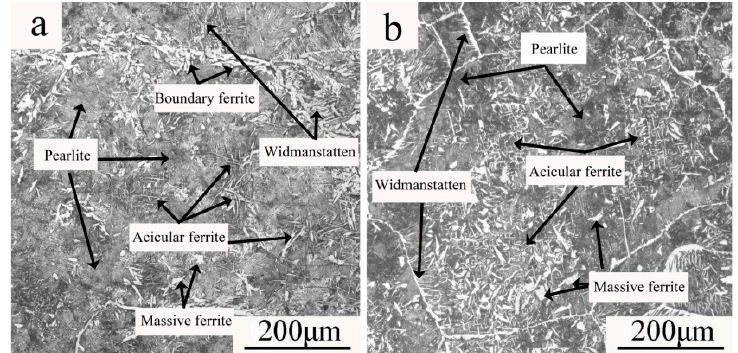
Figure 7. Optical microscope images of samples ( a ) without PMF and ( b ) with PMF.